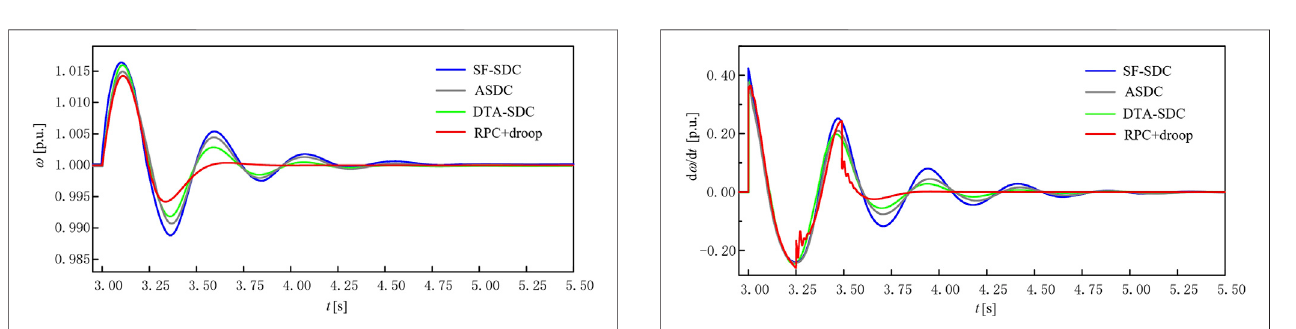
FIGURE 13 | Rotor speed under the state-of-the-art suppression